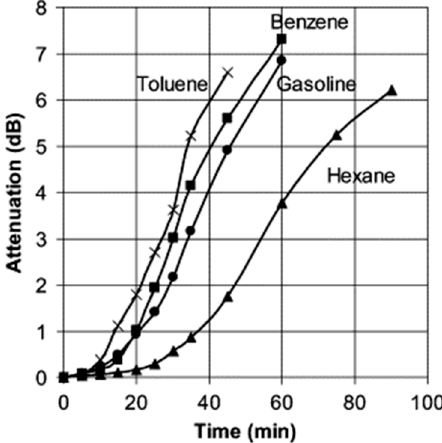
Figure 6. Sensing cable design for a bending loss-based distributed chemical sensor. The polymer will swell in the presence of the analyte, which then pushes the fibre to the wrap and causes fibre loss.